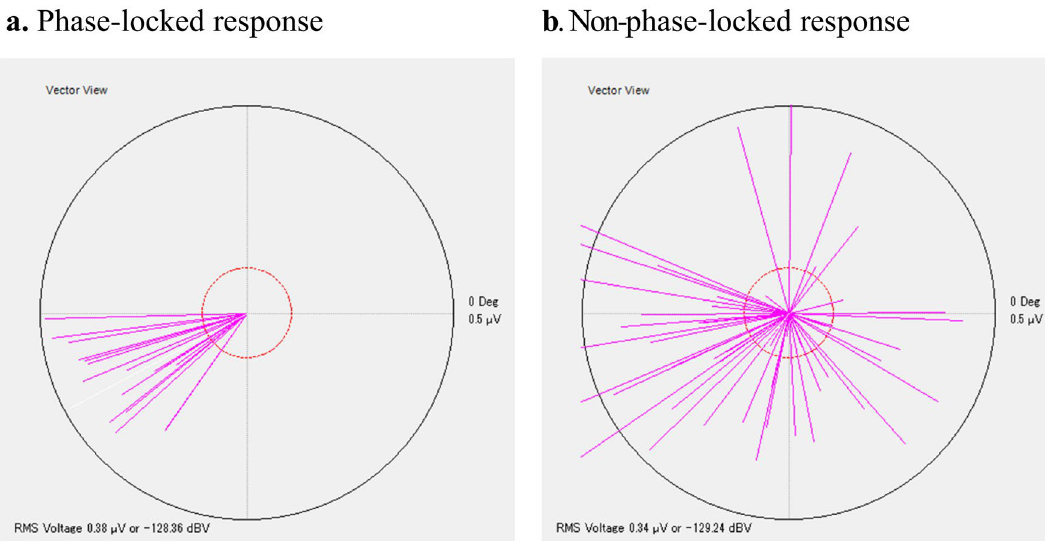
Figure 1. The representative phase-locked ( a ) and non-phase-locked ( b ) responses in 46-Hz AM-FM ASSR in the ERA system. ( a ) and ( b ) are cases of a healthy participant and a patient with schizophrenia, respectively. Each vector in the diagram, which was created by each trial during the auditory stimulus, represents the phase and the amplitude of EEG activity corresponding to the tone modulation frequency rate. The phase angle of the vectors corresponds to the time delay between the presentation of the stimulus and the neural response of trials. The cross-trial phase consistency of the vectors determines the phase-locked or non-phase-locked response. While all trials are aligned in the same range in ( a ), the nonaligned trials that prevent the identification of phase- locked response are seen in ( b ). The mean length of the vectors represents the response amplitude (root mean square voltage, in microvolts) of the ASSR.